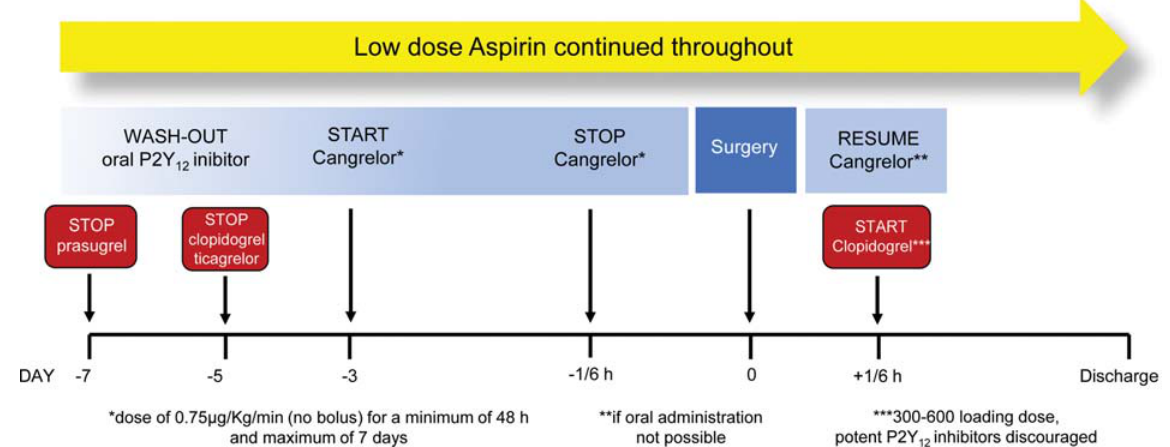
Fig. 1 Standardized bridging protocol using cangrelor infusion before and eventually after nondeferrable surgery which required discontin- uation of one or both antiplatelet agents in patients with previous PCI. 21 PCI, percutaneous coronary